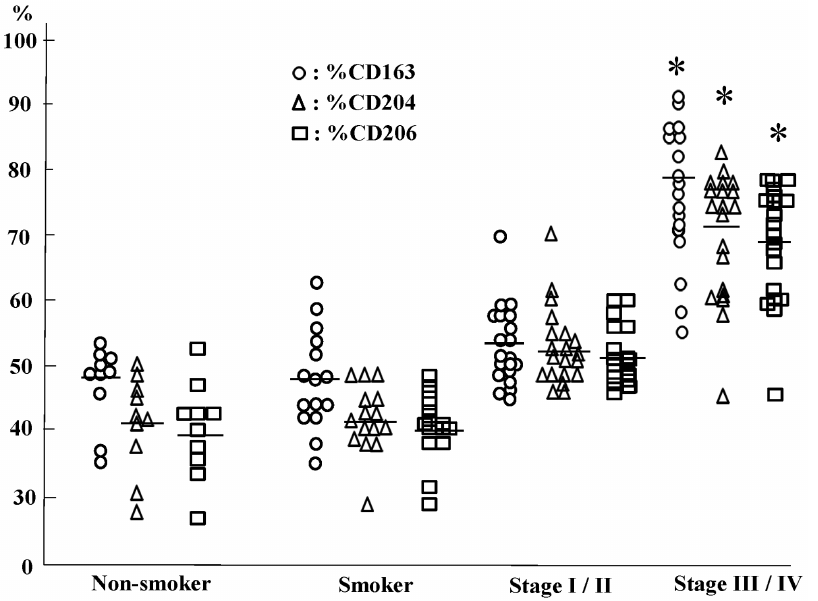
Figure 5. The percentage of CD163, CD204 and CD206 positive cell in non-smoker, smoker and chronic obstructive pulmonary disease patient (COPD). *: p , 0.01 versus nonsmoker, smoker and stage I/II. The Global Initiative for Chronic Obstructive Lung Disease (GOLD) clinical criteria for the diagnosis and severity of COPD stage I: mild, II: moderate, III: severe, IV: very severe.